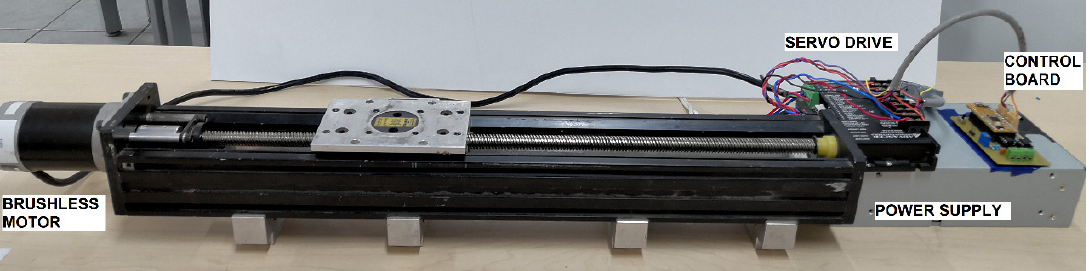
Figure 8. Linear platform to test the control algorithm.